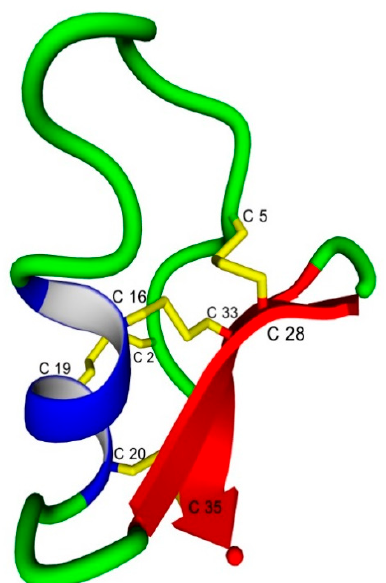
Figure 2. Solution conformation of chlorotoxin (CTX) as determined by 1 H nuclear magnetic resonance spectroscopy (NMR) (Protein Data Bank ID: 1CHL) demonstrating the α -helix (Ala 13 to Cys 20 ) and 2 antiparallel β -sheets (Lys 27 to Tyr 29 and Lys 32 to Leu 34 ) with the four disulfide bonds between: Cys 2 –Cys 19 (I–IV), Cys 5 –Cys 28 (II–VI), Cys 16 –Cys 33 (III–VII), and Cys 20 –Cys 35 (V–VIII) residues, shown in yellow. The N-terminal β -sheet from Cys 2 to Cys 5 is not present in the lowest energy NMR conformation. Secondary structure elements are: α -helix, blue; β -sheet, red; and β -turn/bend/coil, green. Cys side chains and associated disulfide bonds, yellow. Table 1. Peptide naming convention for the Abu- and Ser-substituted chlorotoxin analogs. Native CTX sequence and disulfide bond homology numbering scheme are shown in Figure 1 and Figure 2. Abu Substitution Peptide